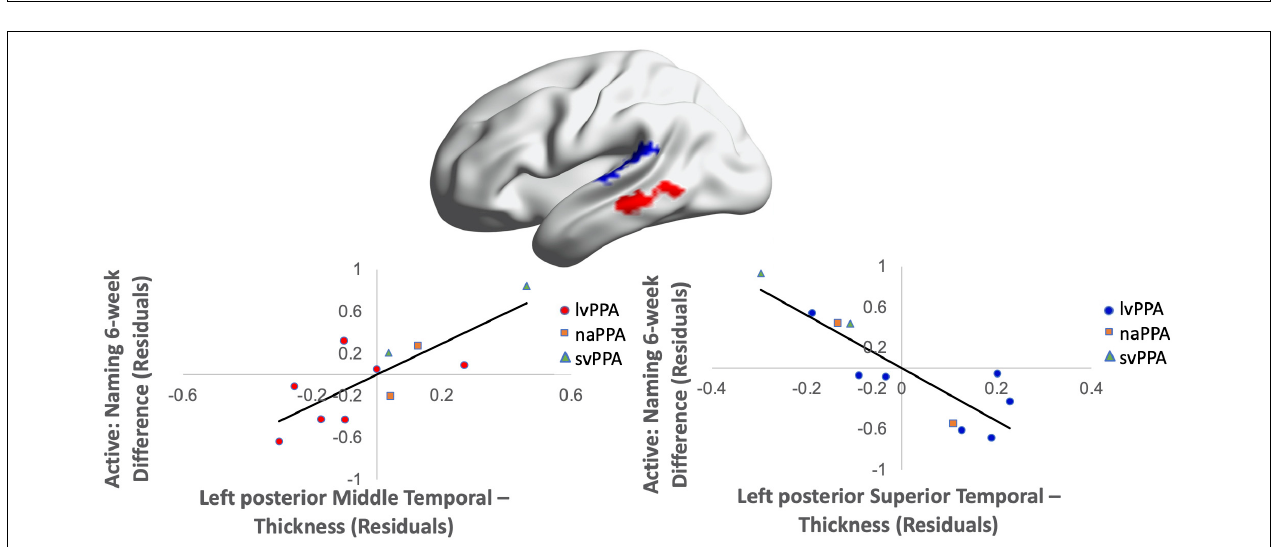
FIGURE 5 | Greater baseline cortical thickness of the MTG (highlighted in red) and lower thickness of the pSTG (highlighted in blue) predicted naming gains in the active condition at 6-week post-intervention (red = greater thickness; blue = lower thickness; R 2 =